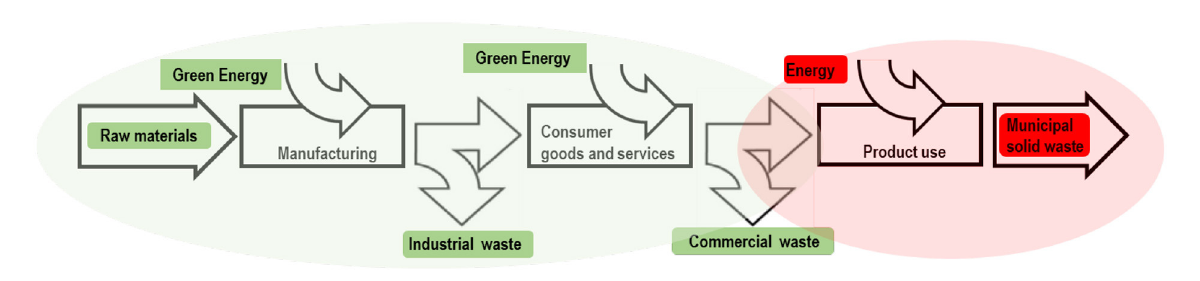
FIGURE3 Reductions in materials, energy use and waste production per economic unit to reduce manufacturing costs, but also increases in overall production and post-consumer waste due to designed obsolesce and increases in demand.